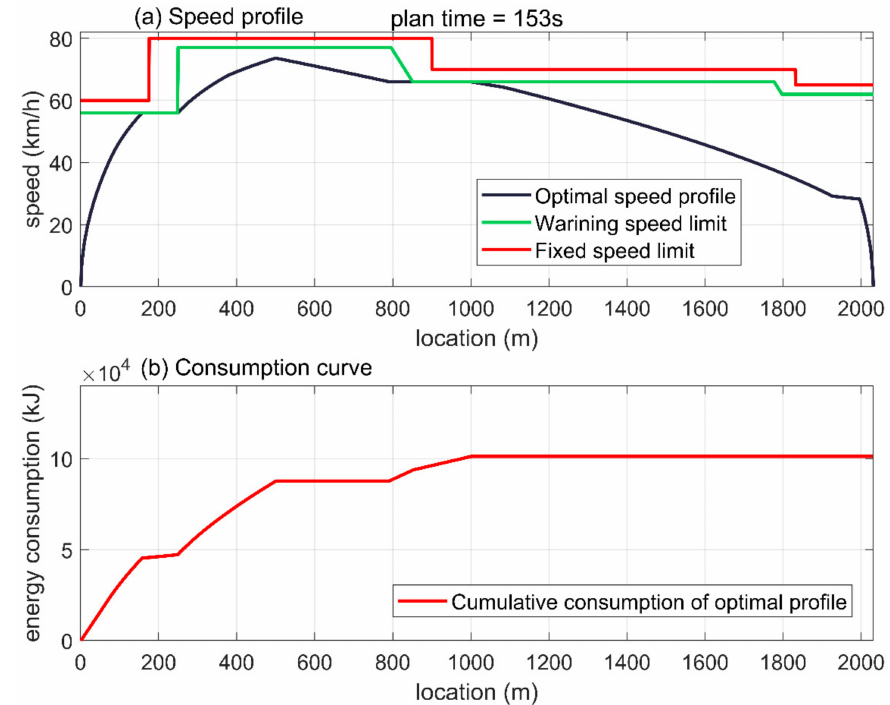
Figure 17. Optimal speed profile. ( a ) The optimal speed profile made by optimization; ( b ) Cumulative energy consumption growth curve.